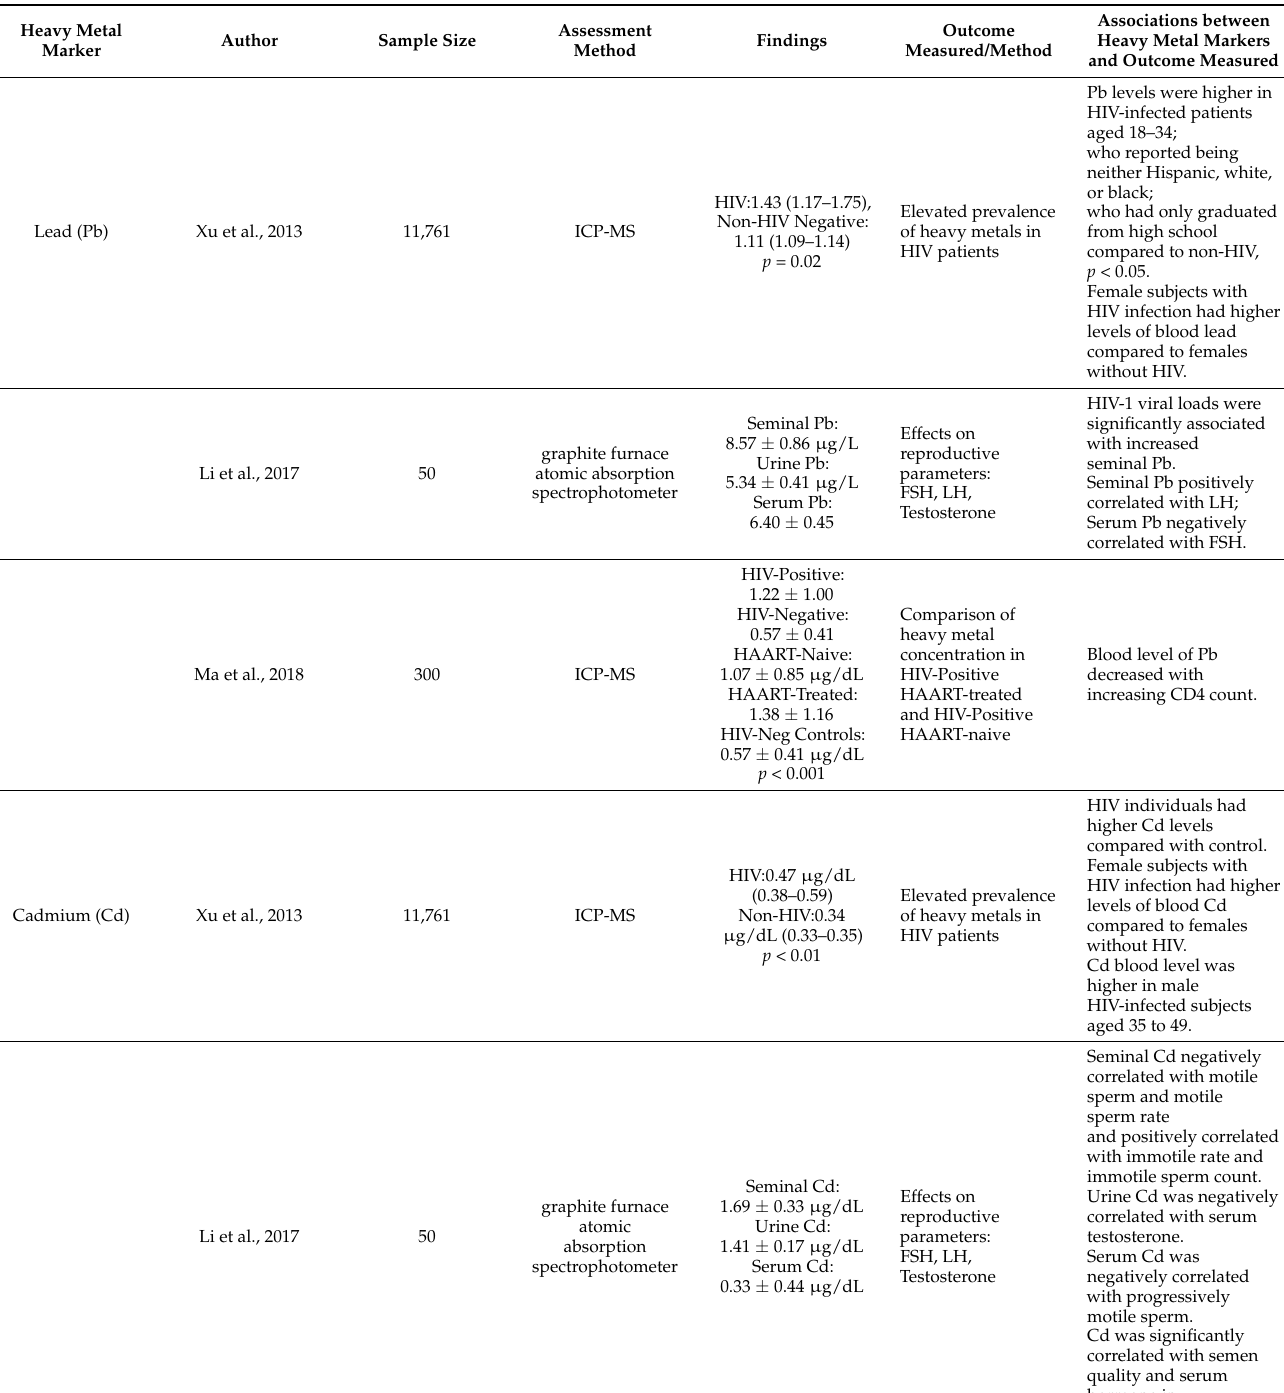
Table 3. Study Findings Stratified by Heavy Metal